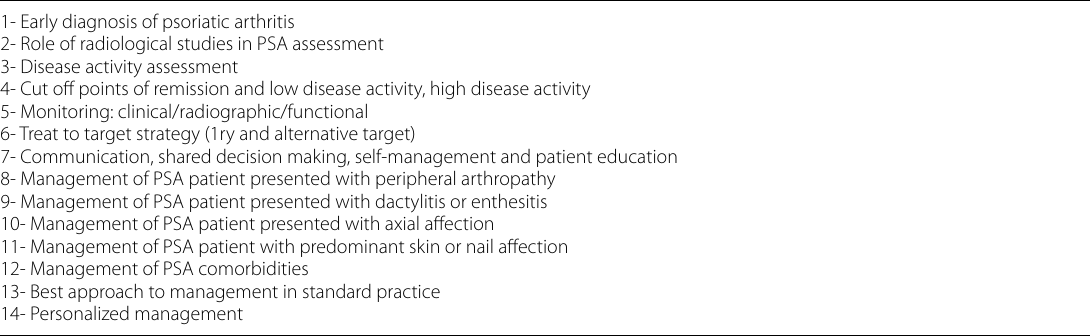
Table 1 Key questions for PSA